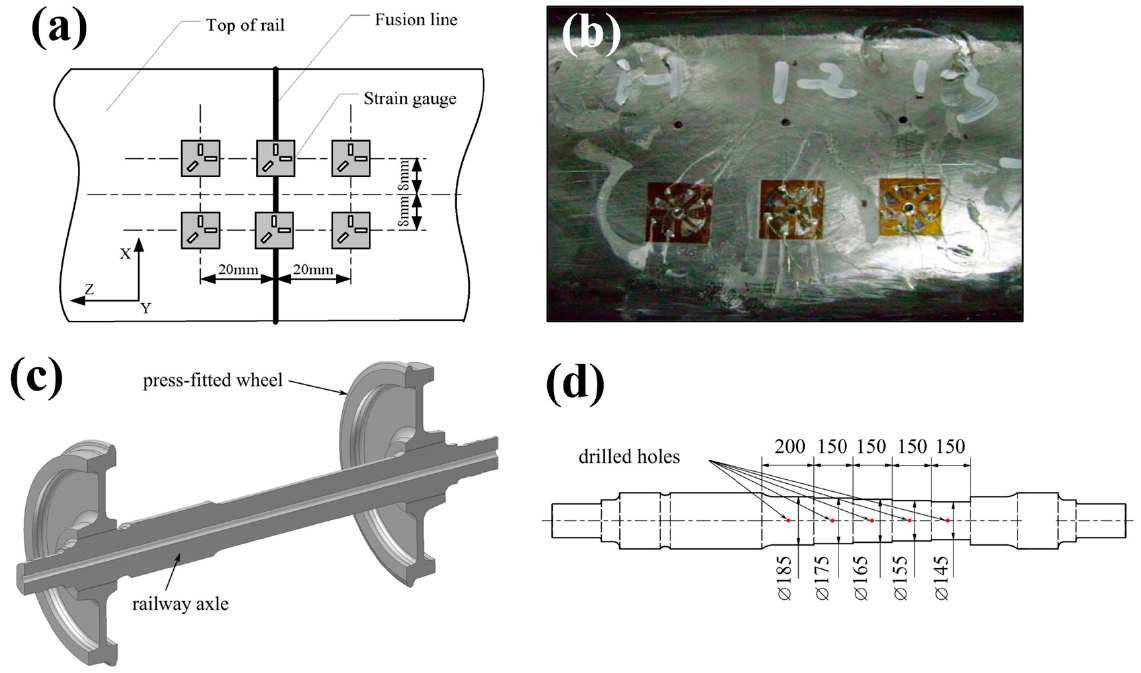
Figure 5. A study by Ma et al. [44] showing ( a ) Hole drilling measurement locations around a weld and ( b ) Hole drilling strain gauges applied to the rail head. A study by Pokorny et al. [47] showing a ( c ) schematic of railway axle and wheel configuration and ( d ) measurement locations after turning to reduce axle diameter for internal measurements.